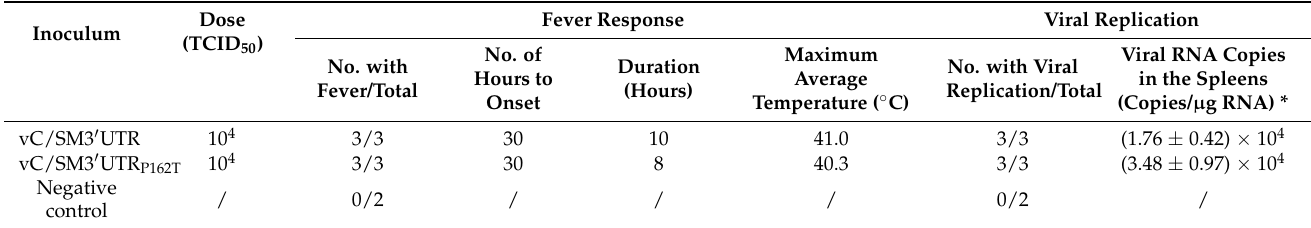
Table 3. Fever response and viral replication in the spleens of the rabbits inoculated with